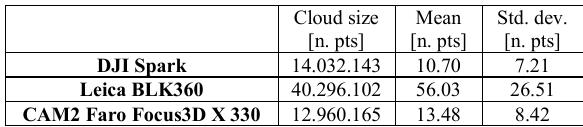
Table 9. Density (Number of neighbours) calculated by pt/V. analysing a sphere with a radius of 10 mm.